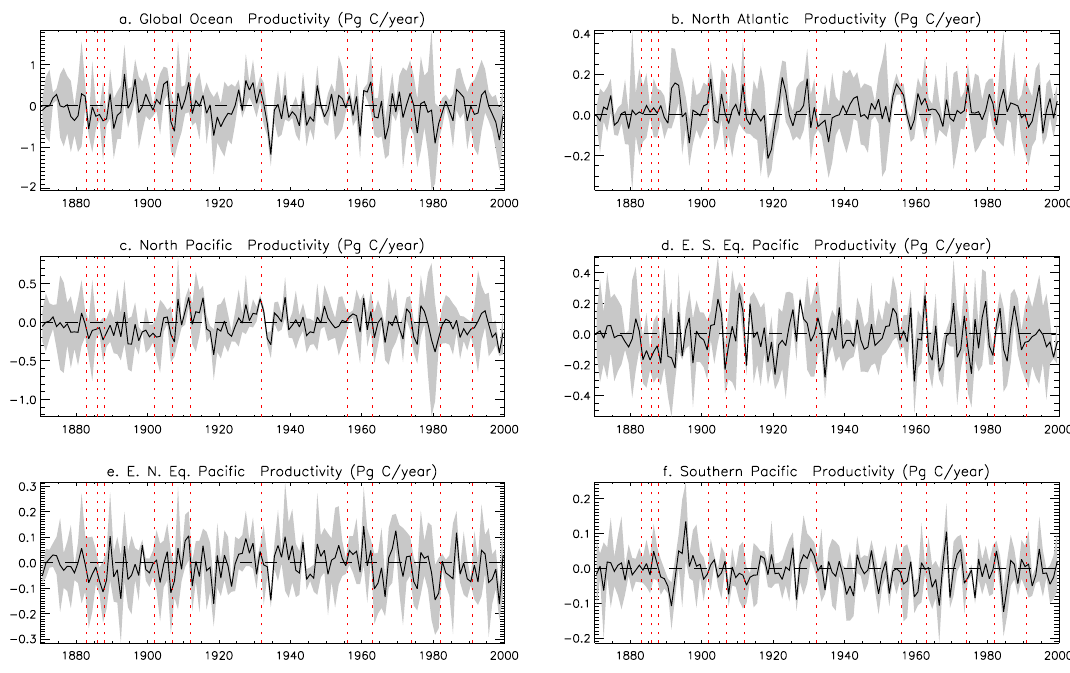
Fig. 11. Changes in ocean productivity (Pgyr − 1 ) for 1870–2000 in the volcano minus control cases. Eastern South equatorial Pacific